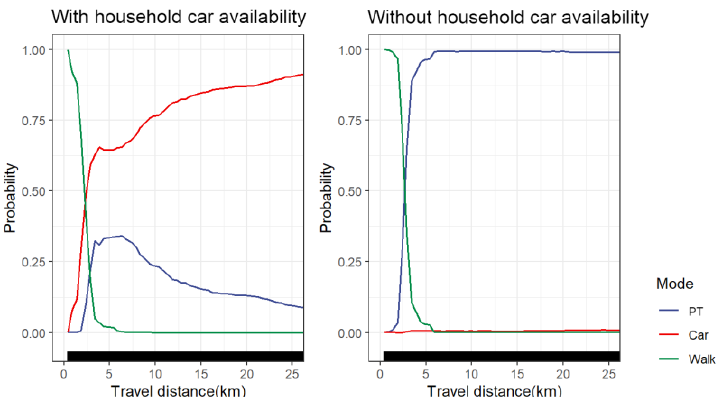
Figure 9. PDP plot of car ownership groups differences.